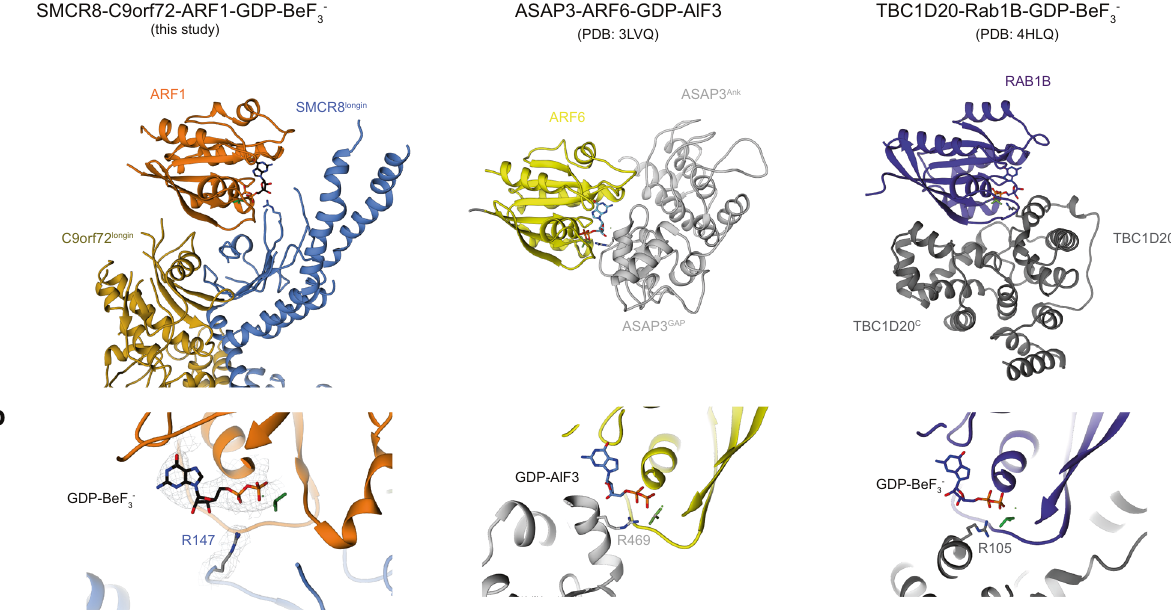
Fig. 3 Structure comparison between C9orf72:ARF1-SMCR8:WDR41 with other GAP:small GTPases. a Structure comparison between C9orf72:ARF1- SMCR8:WDR41 (left) with ASAP3:ARF6 (middle) and TBC1D20:RAB1B (right). The small GTPases are shown in the same orientations. b Close-up views of the nucleotide-binding sites with catalytic Arginine fi nger residues pointing to the active